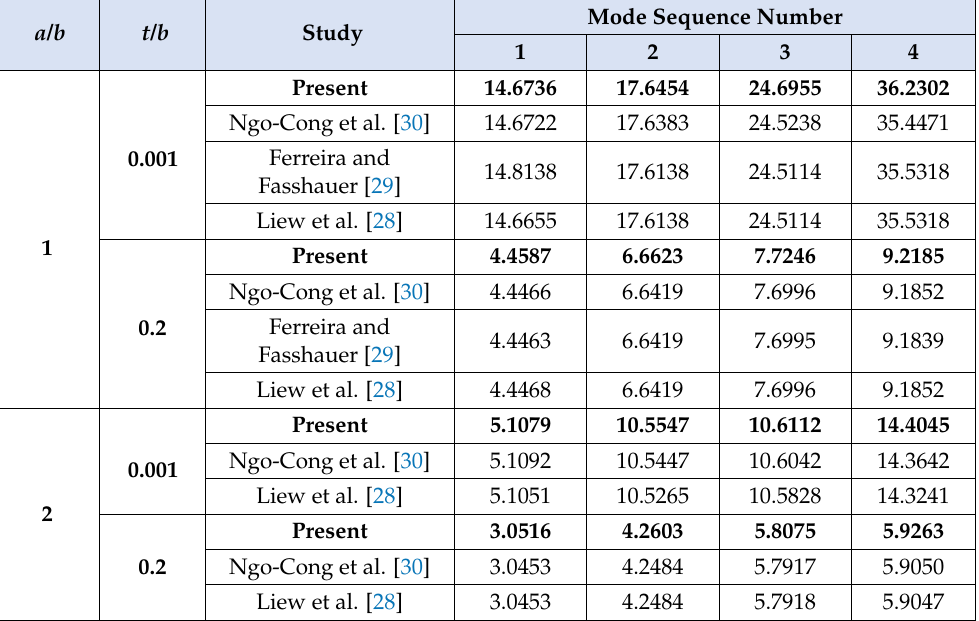
(cid:17)(cid:113) (cid:16) ρ h b 2 ) D 0 2